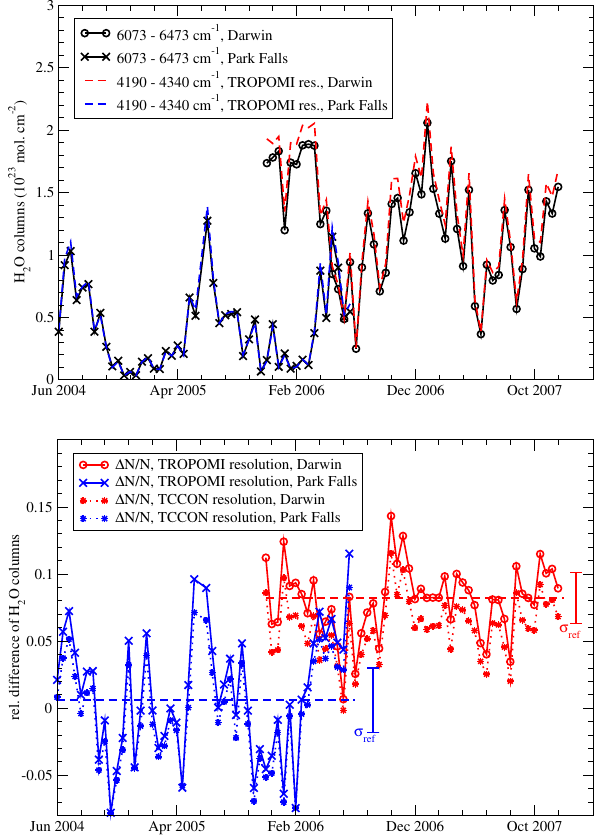
Fig. 6. CO retrieval accuracy at 4190–4340cm − 1 for Darwin (cir- cles) and Park Falls (crosses). The upper panel shows the time- series, the lower panel shows the relative differences between columns retrieved at TROPOMI resolution and columns retrieved from window 5 (original high resolution).